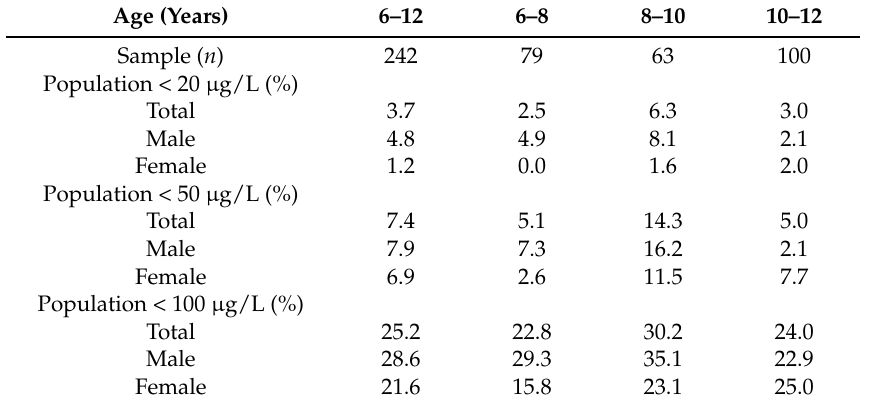
Table 2. Distribution of urinary iodine levels <100 µ g/L, <50 µ g/L, and <20 µ g/L by age and gender.